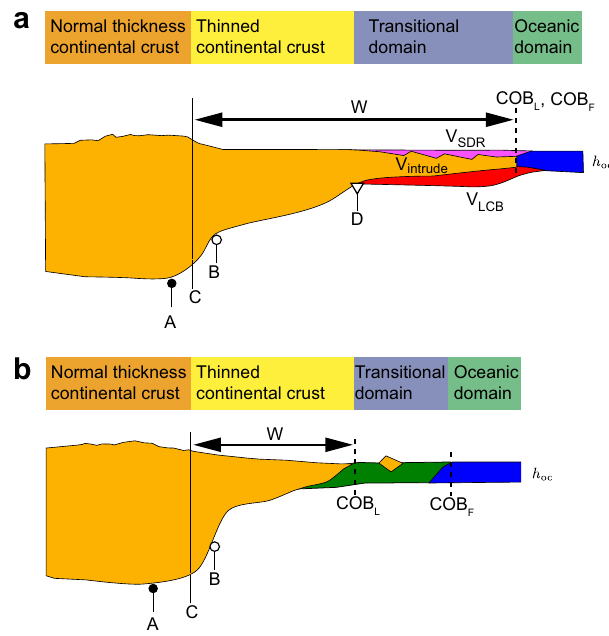
Fig. 5 Schematic plot for margin width de fi nition. a , b Margin width measurements for volcanic and magma-poor margins, respectively. Margin width is de fi ned by the distance between the termination of un-thinned continental crust and the continental ocean boundary (COB). The termination of un-thinned continental crust is de fi ned at the mid point (C) of taper zone that starts from the fi rst crustal thinning (point A) and stops at the location where the Moho reaches a depth of 20 km or fl attens (point B). COB L : last continental crust; COB F : fi rst oceanic